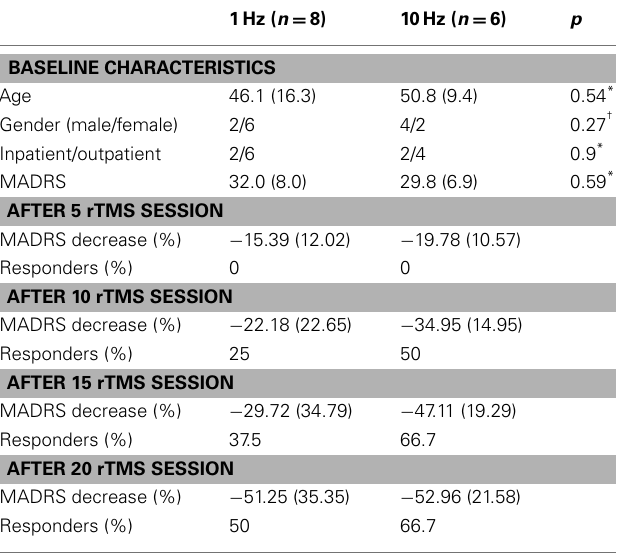
Table 1 | Characteristics of patients throughout the study period.